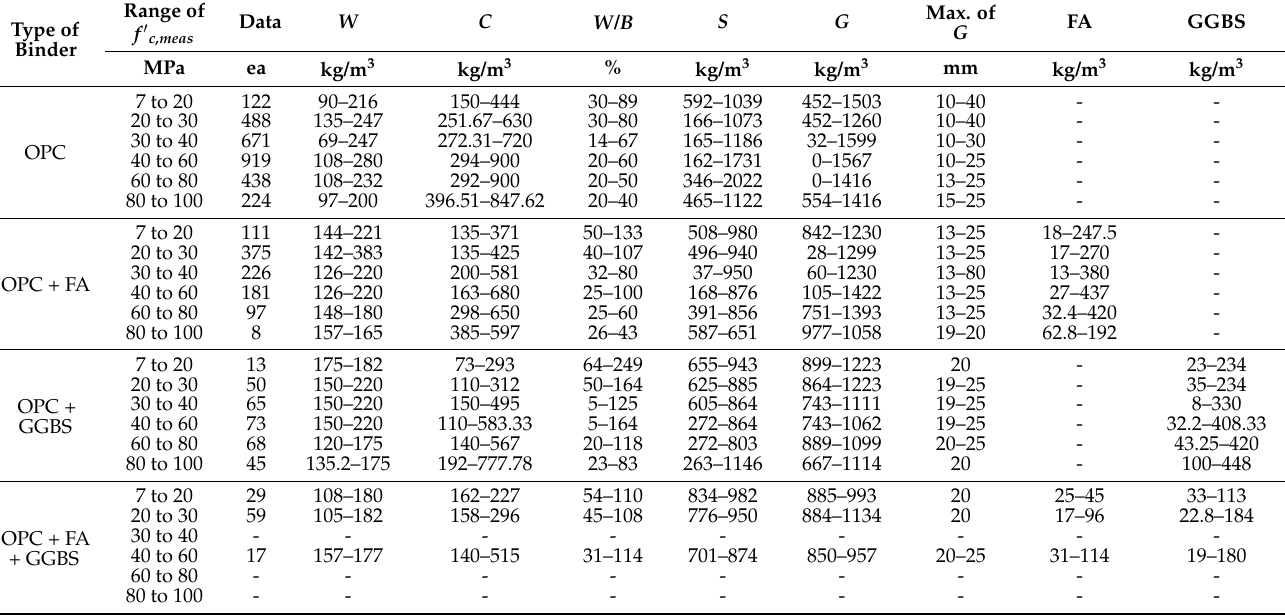
Table 1. Concrete mixtures and measured compressive